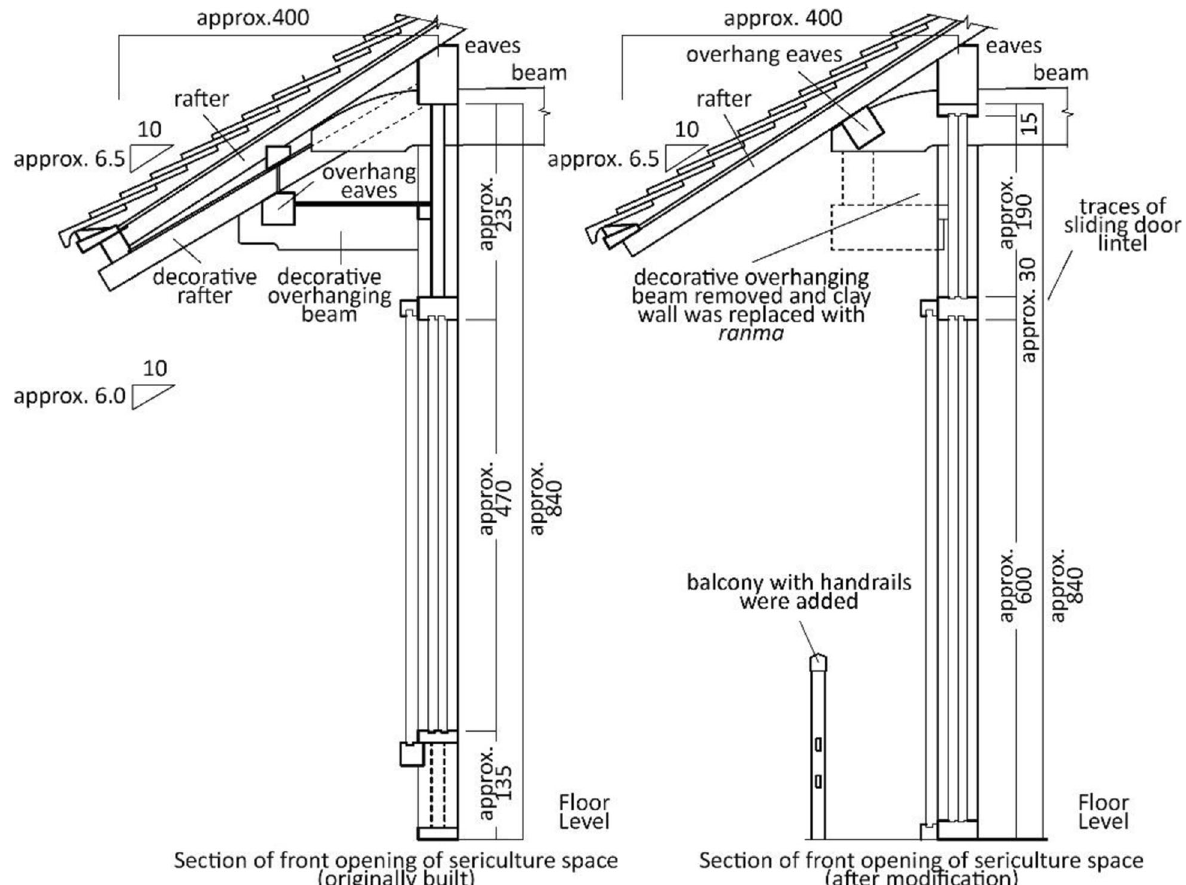
Fig. 4 Section of the front opening of the sericulture space as originally built and after modification. (Source: Satoshi